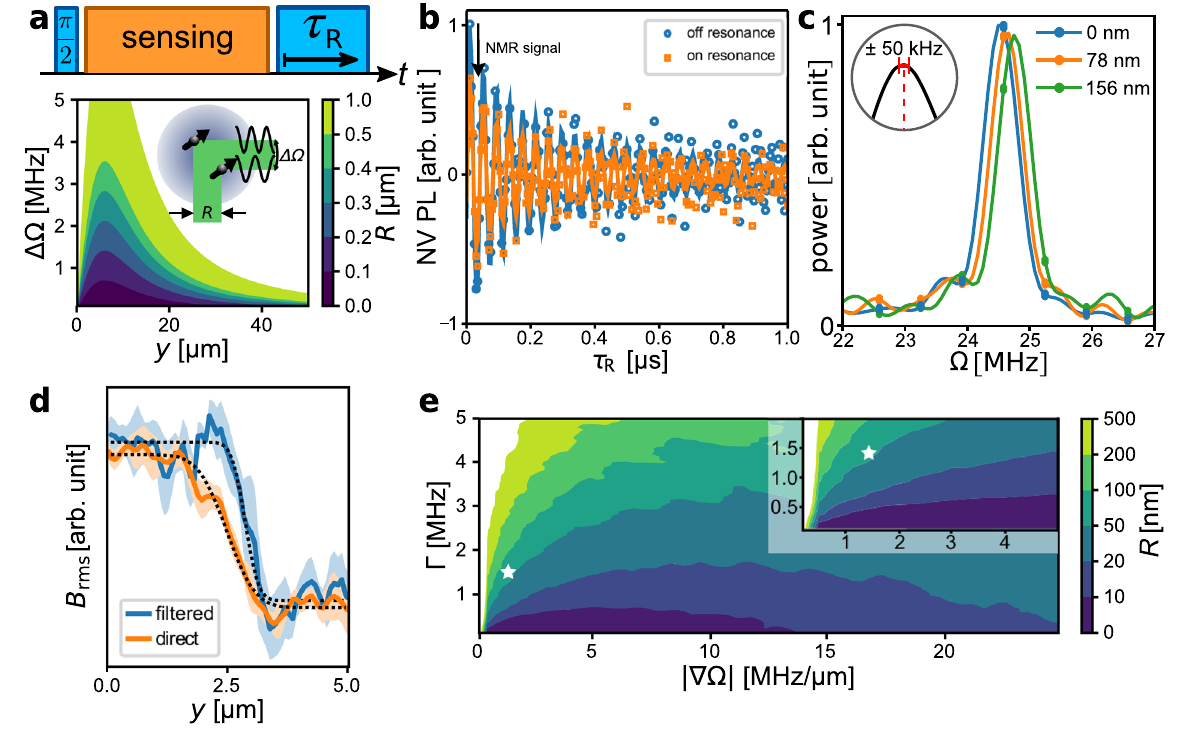
Figure 3. Superresolution in MW gradient. ( a ) A spin state projection pulse with variable duration τ R results in an oscillating sensor response, modulated by the sensing result. Discrimination between spectral components with resolution Δ Ω translates to spatial resolution R at a given distance y from the wire, which is located at y = 0. ( b ) The amplitude of the Rabi readout signal is modulated by the 19 F NMR signal. On resonance, a reduced contrast is obtained. Data are from a single camera pixel, solid lines are least-squares fits. ( c ) Periodograms (with interpolation) of the Rabi oscillations from adjacent pixels clearly reflect the shift of the Rabi frequency within the gradient. Note that upsampling of the frames reduced the effective pixel size, see main text. Inset: Typical uncertainty of the line centres according to the least-squares fits in the time domain. ( d ) Fitting the NMR signal after filtering the spectra recovers sharpened steps at CaF 2 edges. ( e ) Simulated spatial resolution R for a range of gradient strengths | ∇ Ω| and intrinsic spectral linewidths Γ . Star marks experimental conditions. Inset: